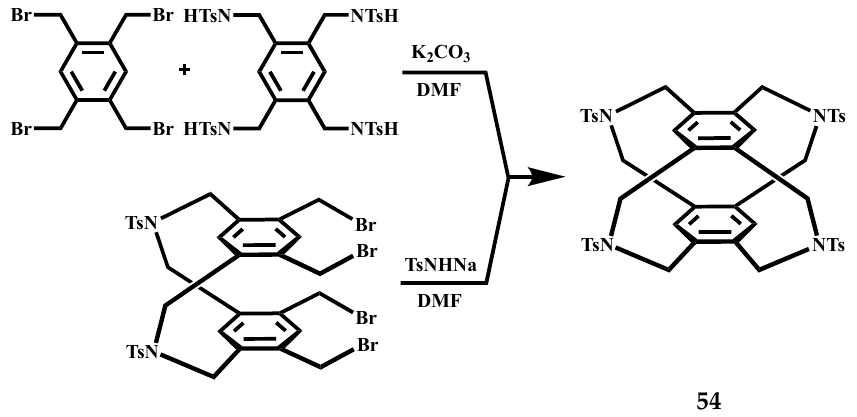
Figure 24. Synthesis of the fourfold-bridged cyclophane 54 .